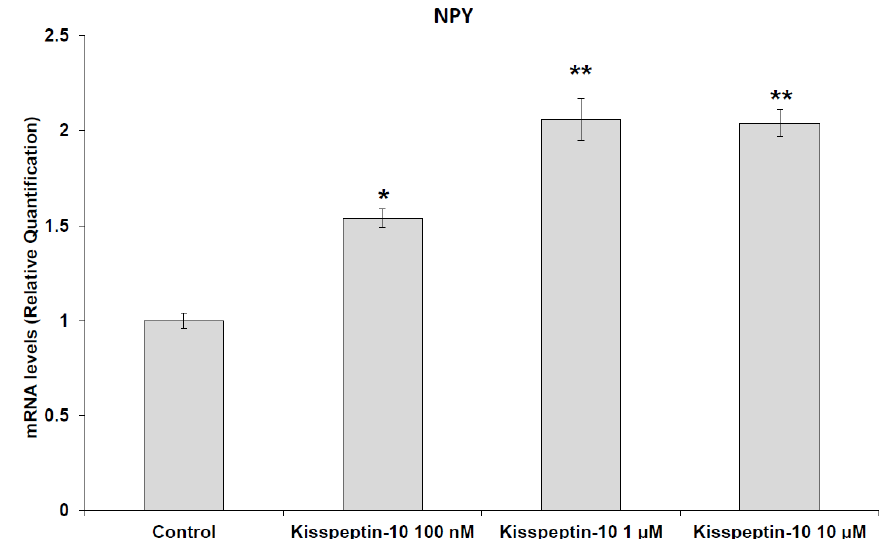
Figure 1. Effect of kisspeptin-10 (100 nM–10 μM) treatment on relative gene expression of neuropeptide Y (NPY), as determined by real-time RT PCR in rat hypothalamic (Hypo-E22) cell line ( n = 5 individual culture flasks for each condition). Data were calculated using the 2 −ΔΔCt method; they were normalized to β-actin mRNA levels and then expressed as relative to vehicle. Compared to control, kisspeptin-10 treatment significantly increased NPY (ANOVA, p < 0.001; post-hoc, * p < 0.05, ** p < 0.001 vs. control) gene expression.